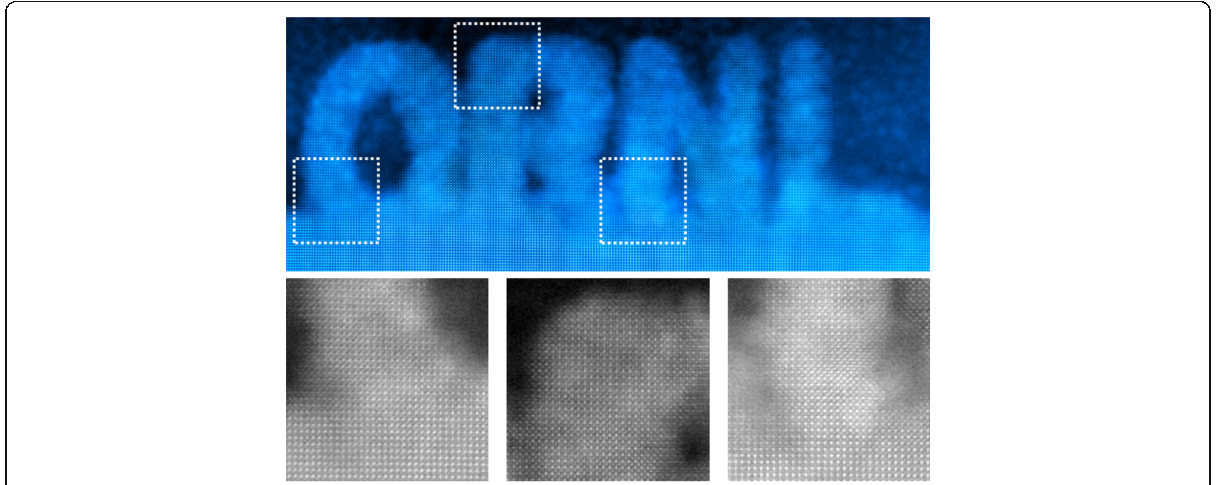
Fig. 18 An example of crystalline oxide sculpting using an arbitrary graphical pattern (in this case, text “ ORNL ” ): Fourier-filtered HAADF image of the ( a ) complete structure and ( b – d ) magnified raw images of the regions at the top and at the base of the patterned letters. Note the same crystallographic orientation in b , c , and d , highlighting the epitaxial character of the growth. The widths of image b , c , and d are 12 nm. Reproduced from Jesse et al.